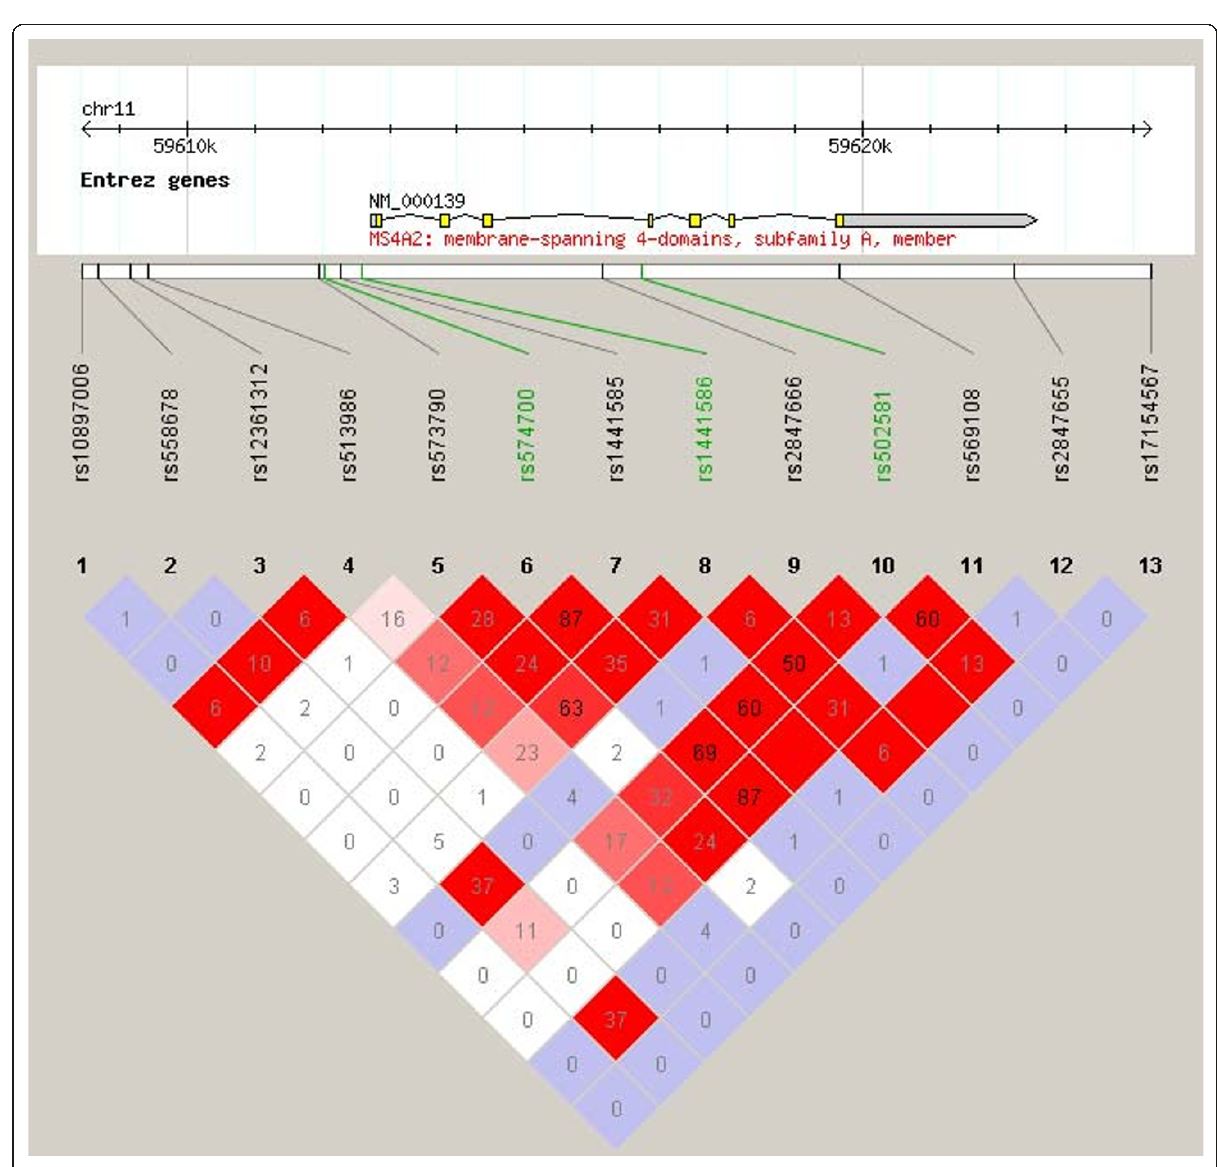
Figure 2 Linkage disequilibrium (LD) observed across SNPs of MS4A2 . r 2 values displayed in triangle plot represent strength of LD between SNPs . Color scheme: white (weakest LD): D ’ < 1, LOD < 2; blue: D ’ = 1, LOD < 2; shades of pink/red: D ’ < 1, LOD ≠ 2; bright red (strongest LD): D ’ = 1, LOD ≠ 2. SNPs in study population indicated in green, HapMap SNPs in black. HapMap data specific to the individuals of African ancestry from the South West United States (ASW)